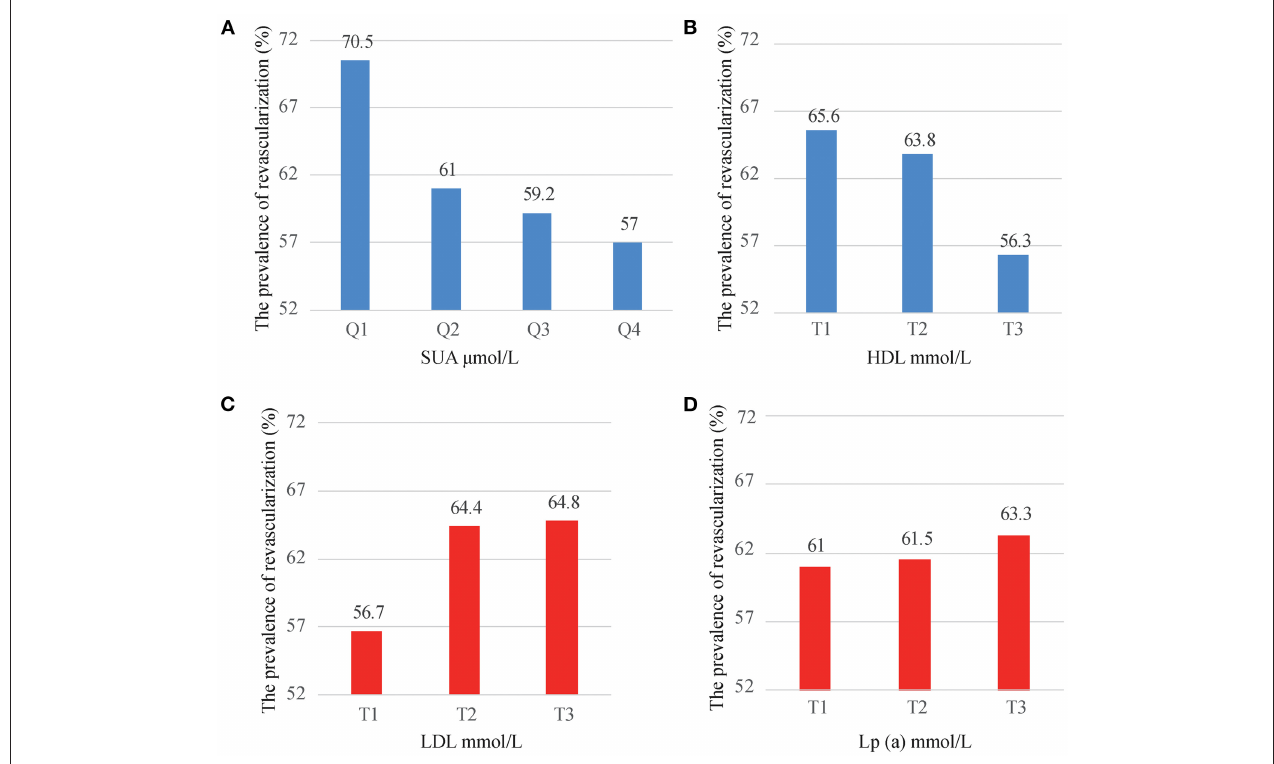
FIGURE 2 | The prevalence of myocardial revascularization grouped by SUA quartiles ( A ), HDL tertiles ( B ), LDL tertiles ( C ), and Lp(a) tertiles ( D ).